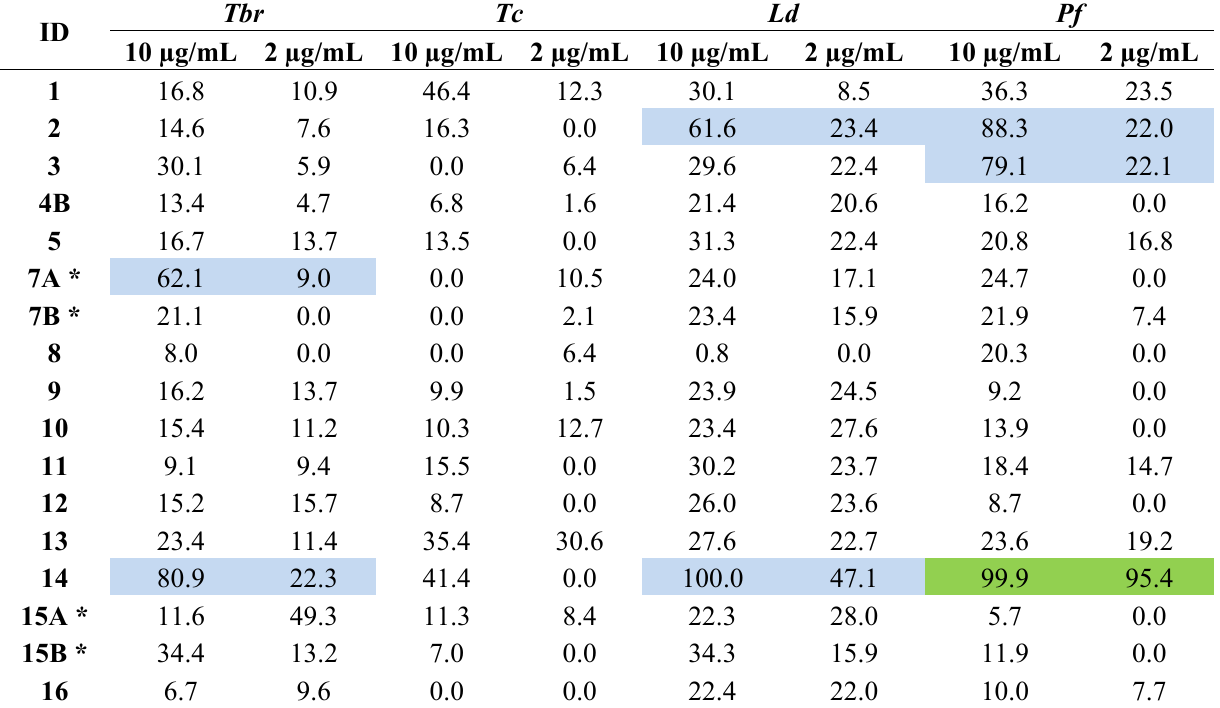
Table A2. Percent Growth Inhibition (GI) values of the tested extracts. Highlighted in Blue: Extracts with 2 < IC 50 < 10 µg/mL. Green: Extracts with IC 50 < 2 µg/mL. A and B indicates those preparations which were prepared with two different extraction methods. (See Tables 1 and